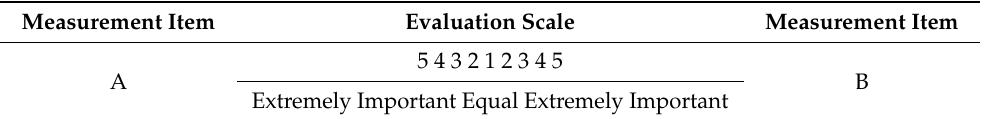
Table A2. Evaluation scale.